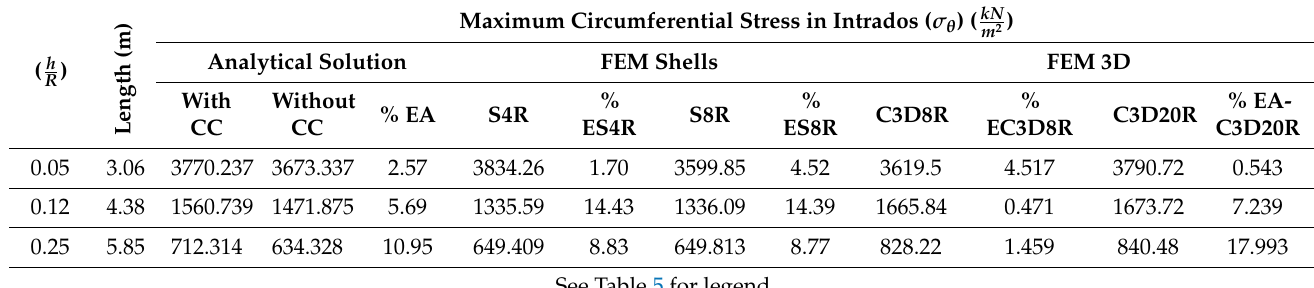
Table 6. Maximum circumferential stress in intrados for different